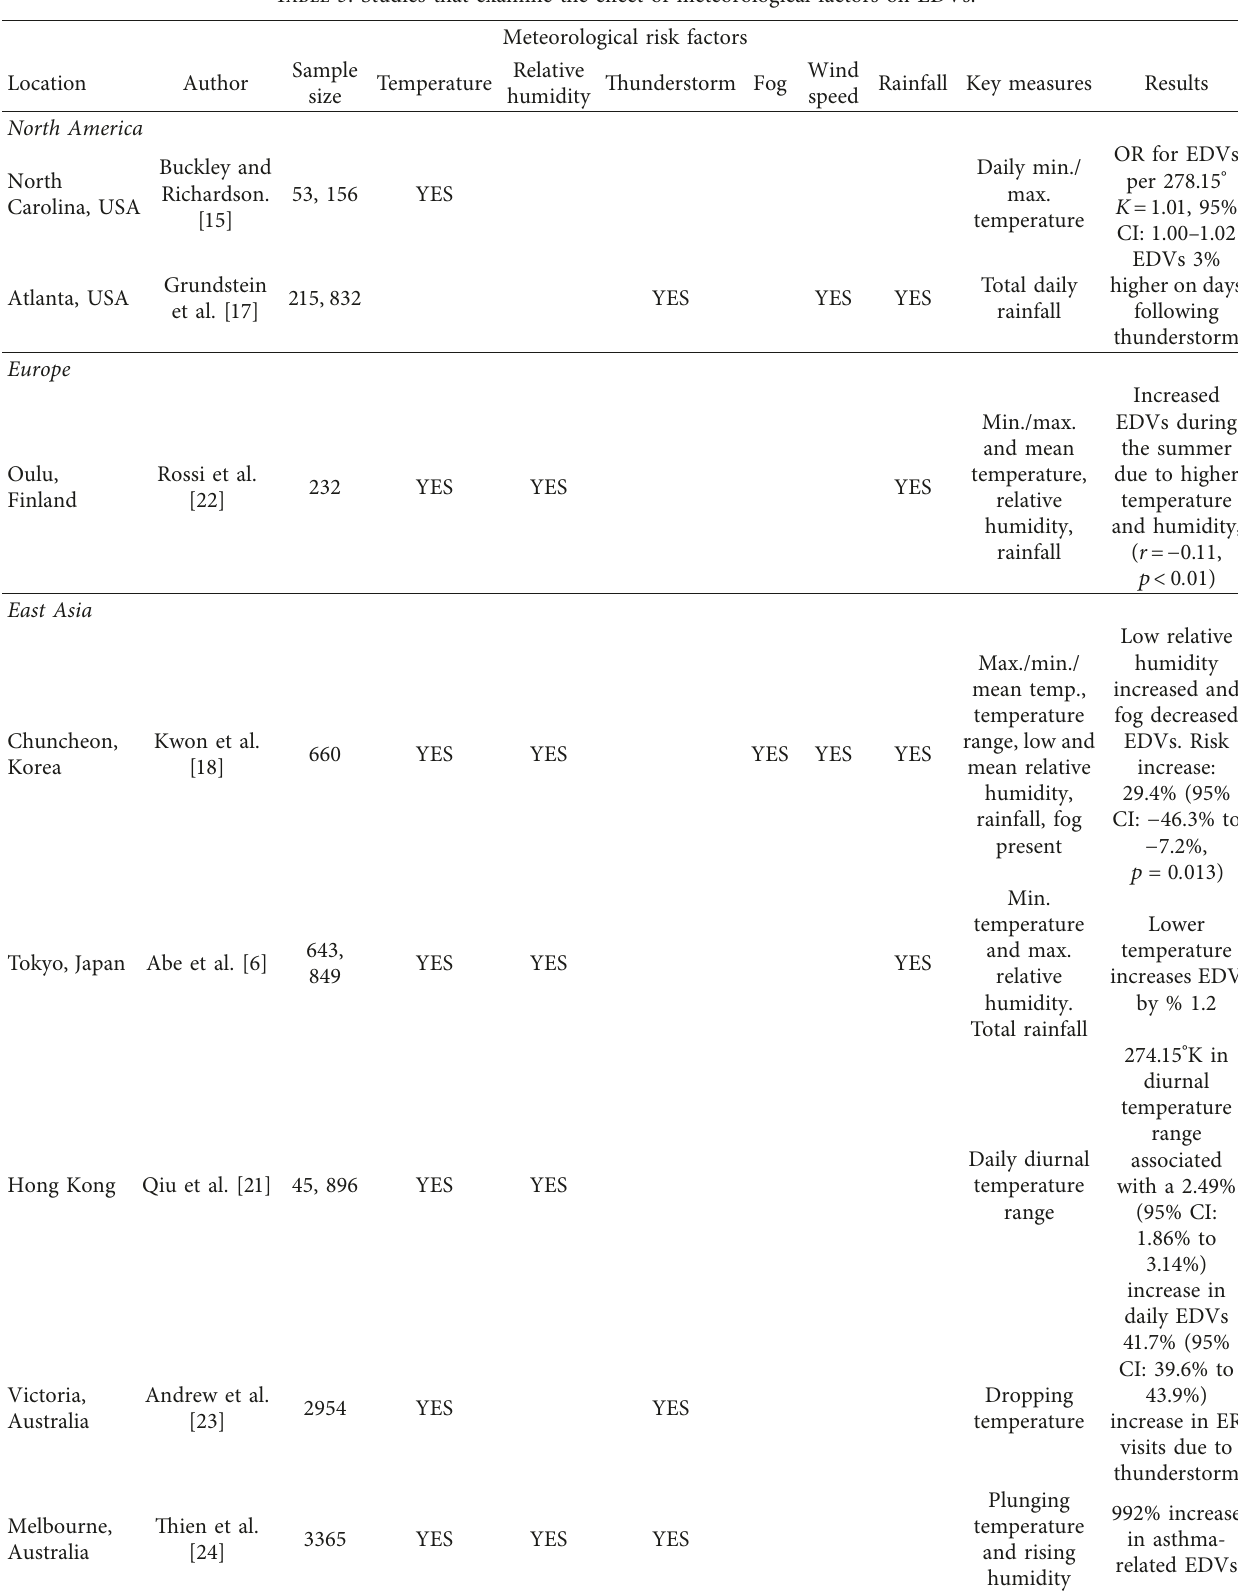
Table 3: Studies that examine the effect of meteorological factors on